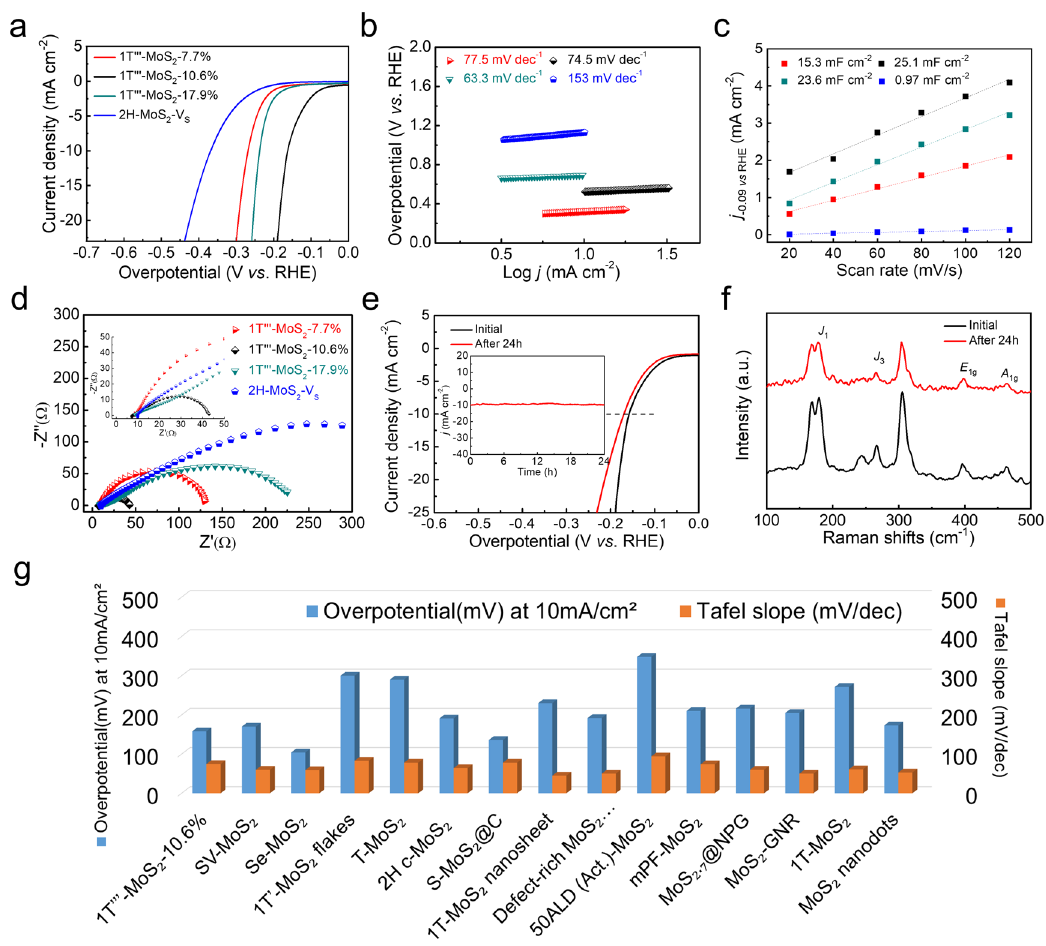
d Nyquist plots of 1T'''-MoS 2 -V S (V S =7.7%, 10.6%, 17.9%) and 2H-MoS 2 -V S . e LSV curves of 1T'''-MoS 2 − 10.6% before and after 24h of durability test. (Inset: the long- term durability tests at η =158mV) ( f ) Raman spectra of 1T'''-MoS 2 − 10.6% before and after 24h test. g Overpotentials at current density of 10mAcm − 2 of 1T'''- MoS 2 − 10.6%and2H-MoS 2 -V S catalystsincomparisontovaluesreportedpreviously for HER catalysts in acidic